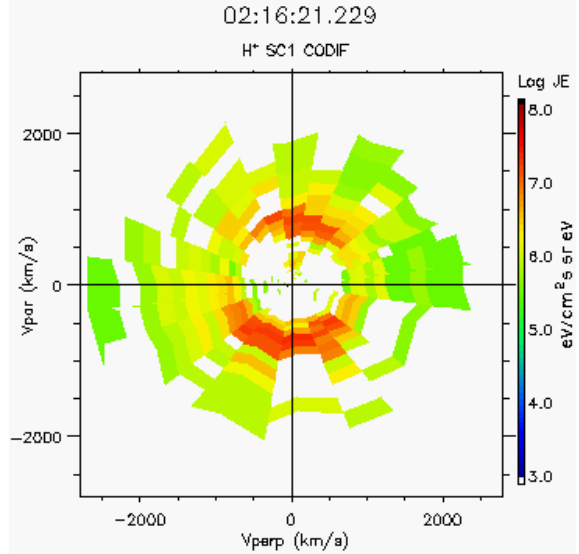
Fig. 8. Distribution function measured by CODIF in the PSBL. The V par axis is along the magnetic field while V perp is included in the plane defined by the magnetic field and the flow velocity. One notes the presence of ∼ 3keV ions streaming to and from the Earth, a typical PSBL